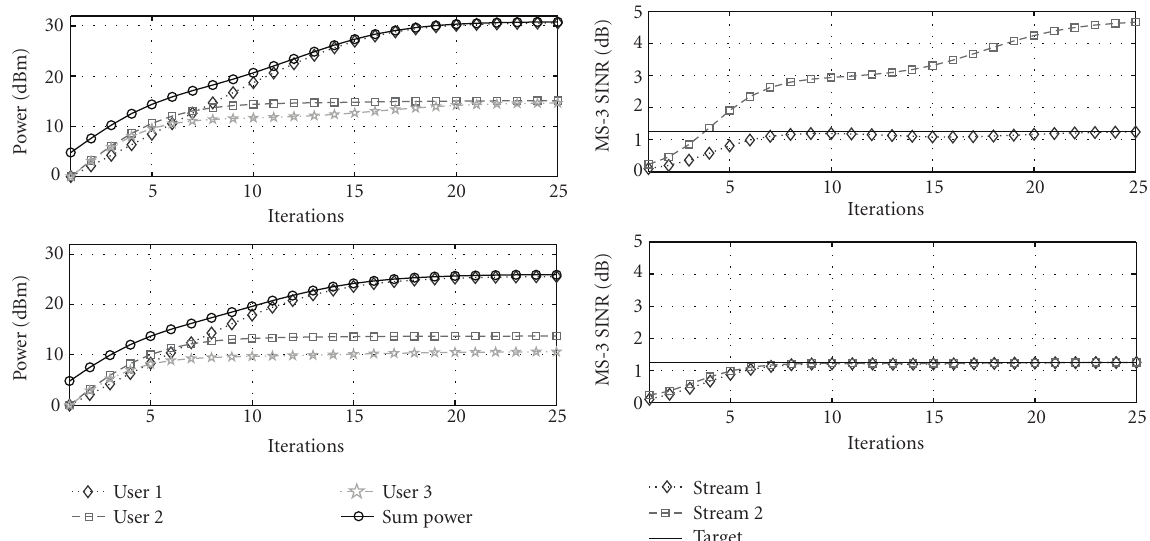
(b) SINRevolutionfor the two streams of MS-3 inCase4. Thefigure is similar to Figure , but now precoding helps to reduce the higher SINR streams SINR from around 5 (7dB) to 1.2 (0.8db)